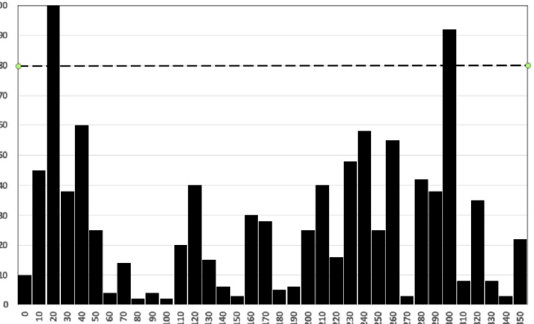
Figure 3. Example of a gradient orientation histogram for an FRI. The horizontal axis represents the gradient orientation in a 10-degree interval and the vertical axis shows the accumulated gradient magnitude.